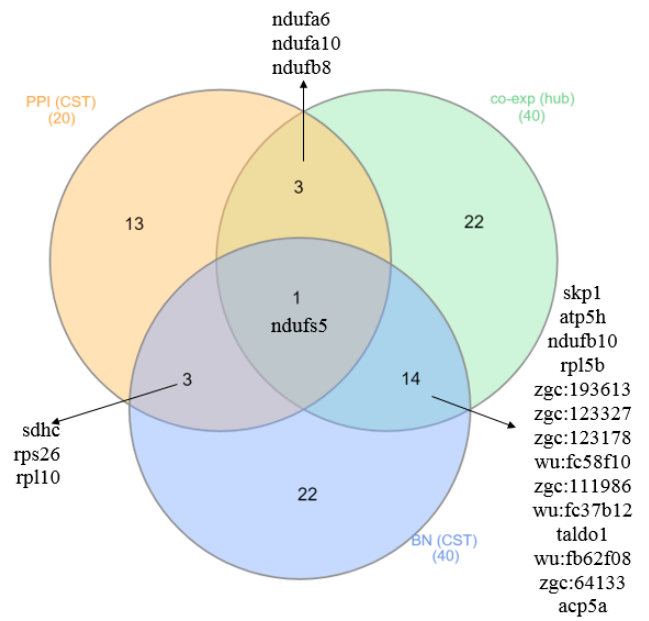
Figure 11. Shared and hub-causative genes between PPI, BN and COEX networks in the liver of zebrafish affected by starvation.